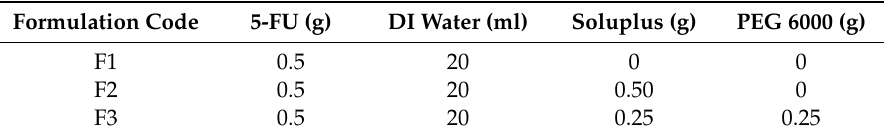
Table 1. Coating formulation compositions of 5-fluorouracil